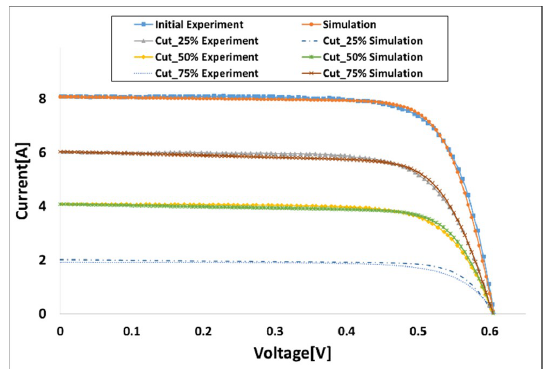
Figure 17. Current-voltage characteristic curve in experimental and simulation results for a cut c-Si solar cell.